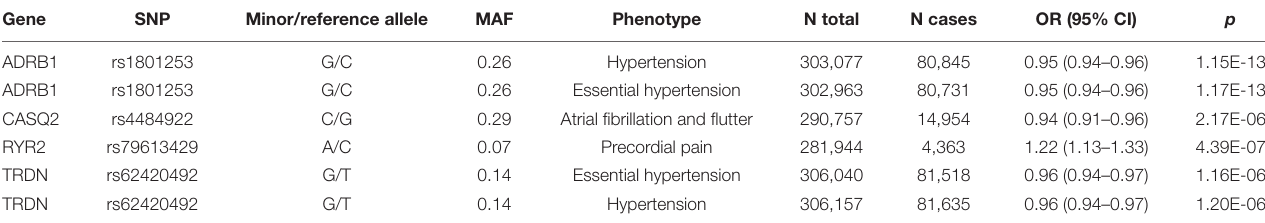
TABLE 1 | The associations between SNPs and CVDs that reach significant or suggestive level.